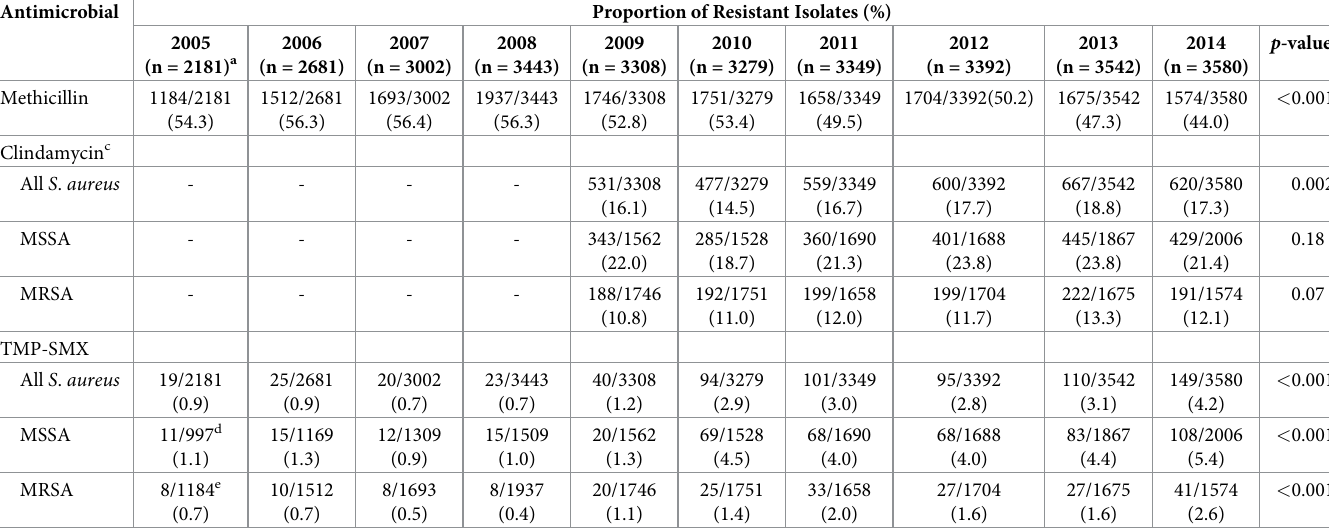
Table 2. Antimicrobial resistance per year among all S . aureus , MSSA, and MRSA outpatient isolates from NCH (2005–2014).